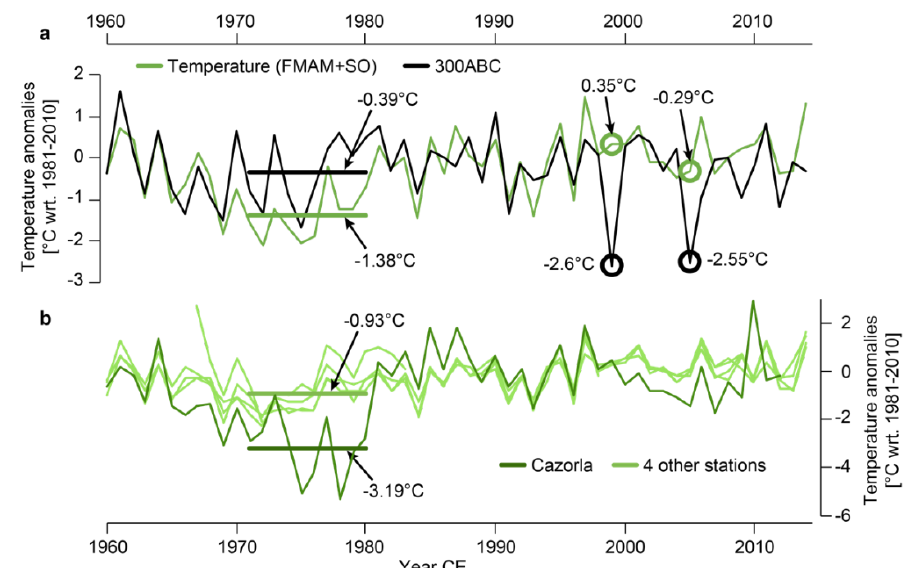
Figure 7. Post-1960 recorded and estimated temperatures. ( a ) Mean February–May and September–October (FMAM&SO) temperatures from five instrumental stations in Albacete, Cazorla, Ciudad Real, Jaen, and Murcia (green curve). The black curve is the ABC300 chronology scaled to the temperature timeseries from 1905–2014. Horizontal bars indicate the mean temperatures from 1971–80. Circles indicate the temperatures in the (proxy) extreme years 1999 and 2005. ( b ) The FMAM&SO temperature records form Cazorla (dark green) and the four other stations (light green) since 1960. Note the gaps in the station records, e.g., before 1968 in Jaen. Horizontal bars as in ( a ).